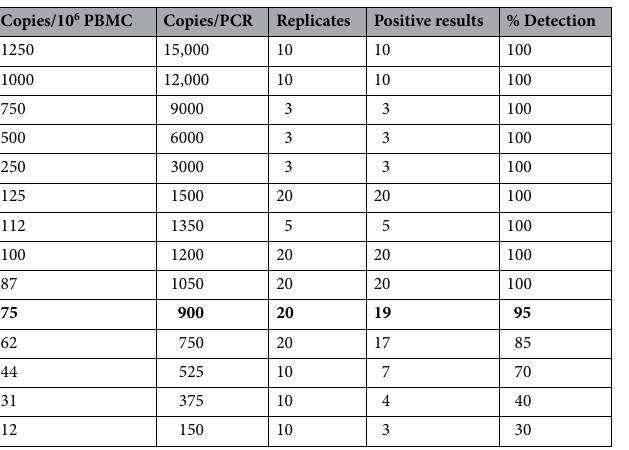
Table 1. LOD95% of the HIV DNA target in FAM. The LOD95% experiment with each concentration tested indicated in copies/10 6 PBMC and copies/PCR, the number of replicates performed, the number of positive results, and the percentage detection (positive results/total of replicates). The estimated LOD95% is shown highlighted in bold in the